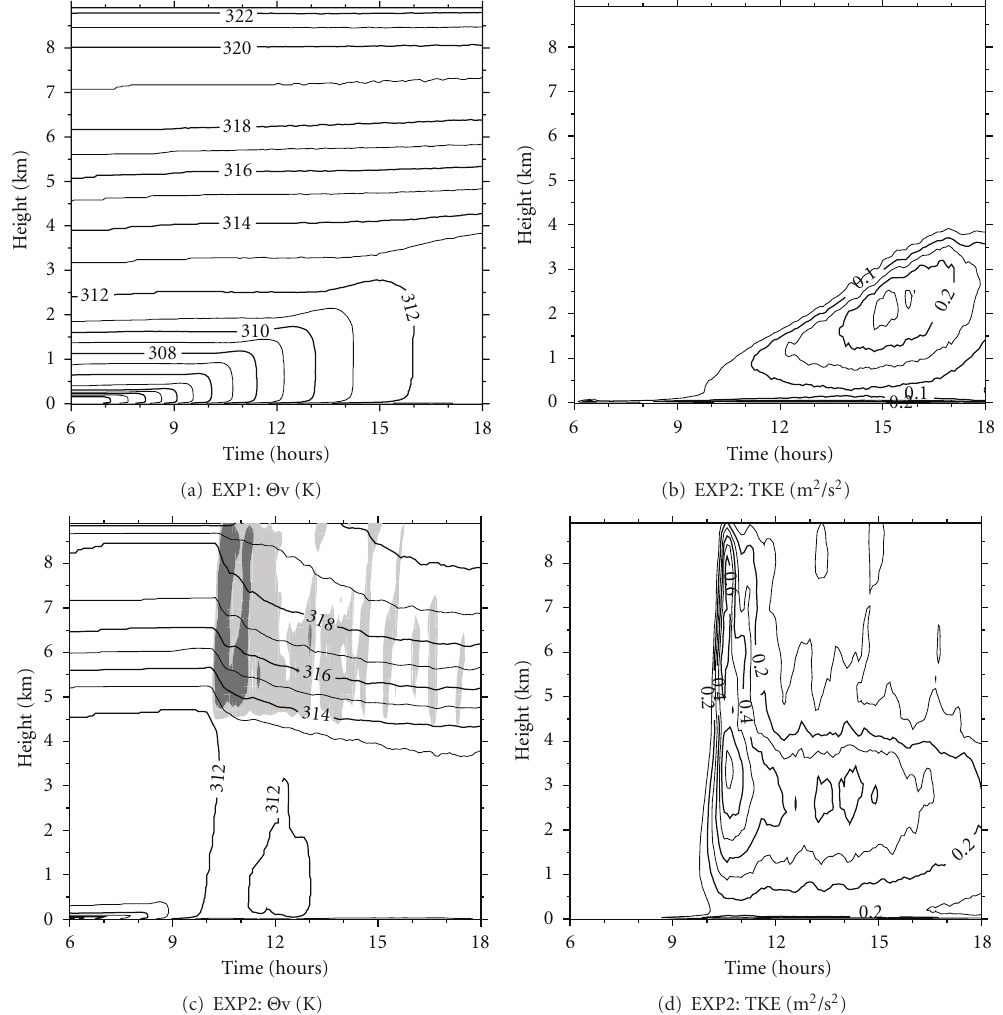
Figure 2: Time-height section of horizontally averaged virtual potential temperature for (a) EXP1 and for (c) EXP2 (both contoured at 1-K interval) and turbulent kinetic energy for (b) EXP1 (contoured at 0.05-m 2 s − 2 interval) and for (d) EXP2 (contoured at 0.1-m 2 s − 2 interval). In (c) the region with cloud water plus ice mixing ratio of 0.025–0.05 g kg − 1 is lightly shaded and the region with the mixing ratio greater than 0.05 g kg − 1 is darkly